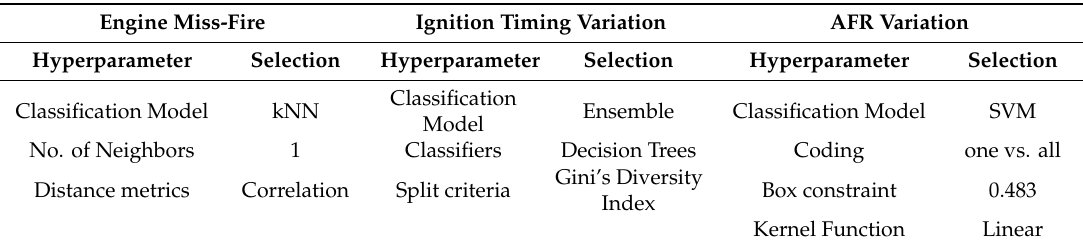
Table 6. Optimal parameters for Model 3—using PCA in addition to Bayesian optimization.